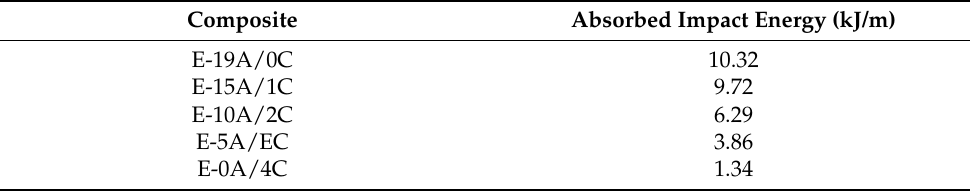
Table 9. Charpy impact results of absorbed energy by the investigated